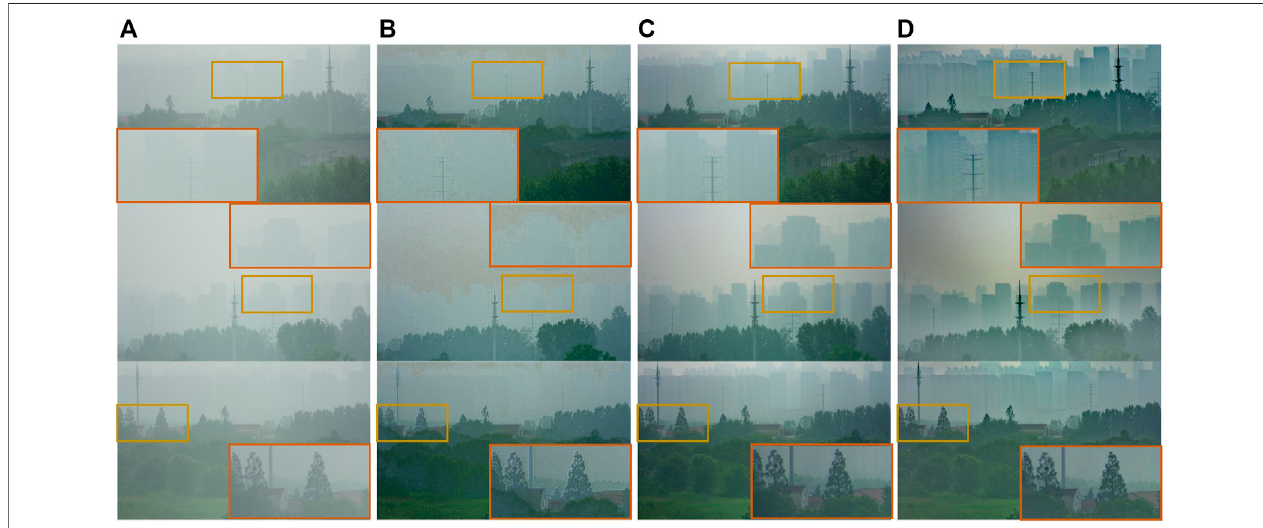
FIGURE4| Theperformanceofdifferentmethodsinrealhazeimagescollectedbyourselves. (A) Originalsceneimage. (B – D) ResultoftheAOD-Net,DCPmethod, and the proposed method respectively.